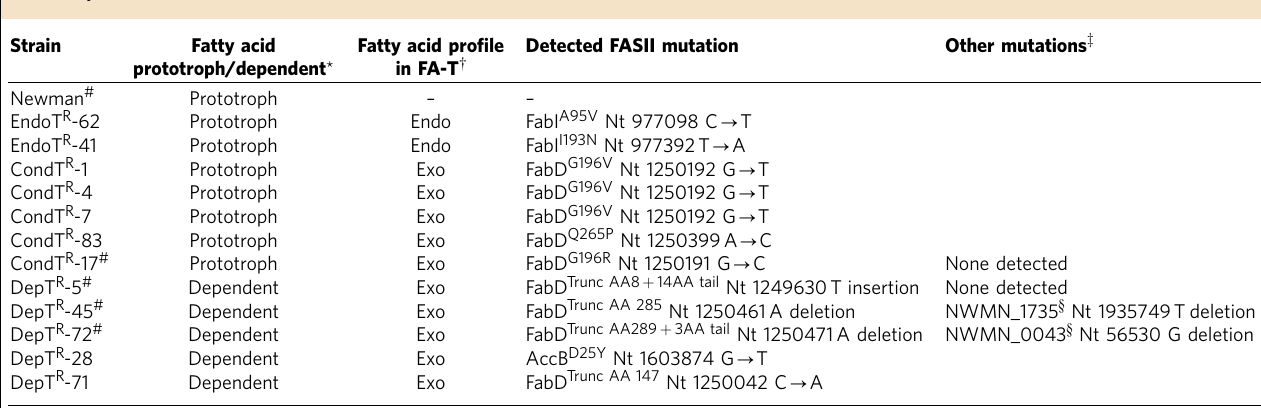
Table 1 | Characterization of FA-T R mutants.